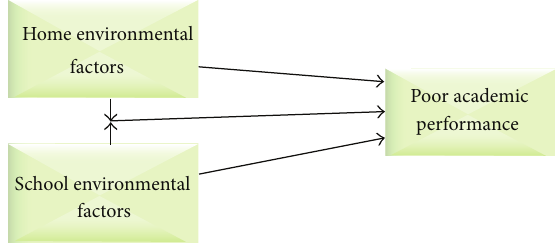
Figure 1: Conceptual framework on causes of poor academic performance. Source: authors’ construct